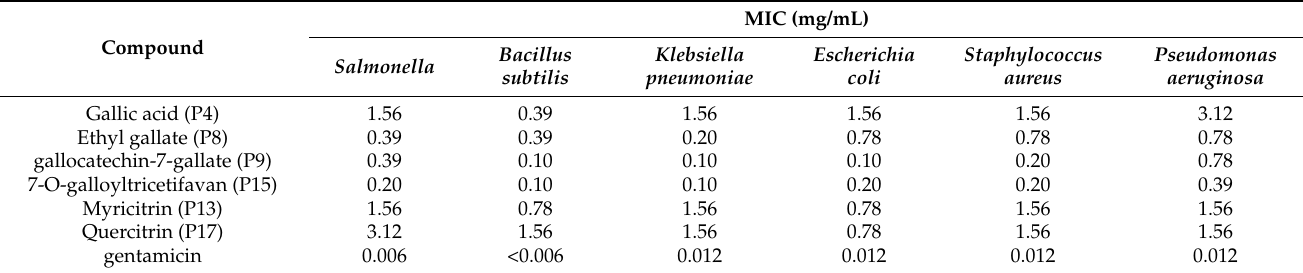
Table 5. MIC values of isolated compounds for six bacteria.